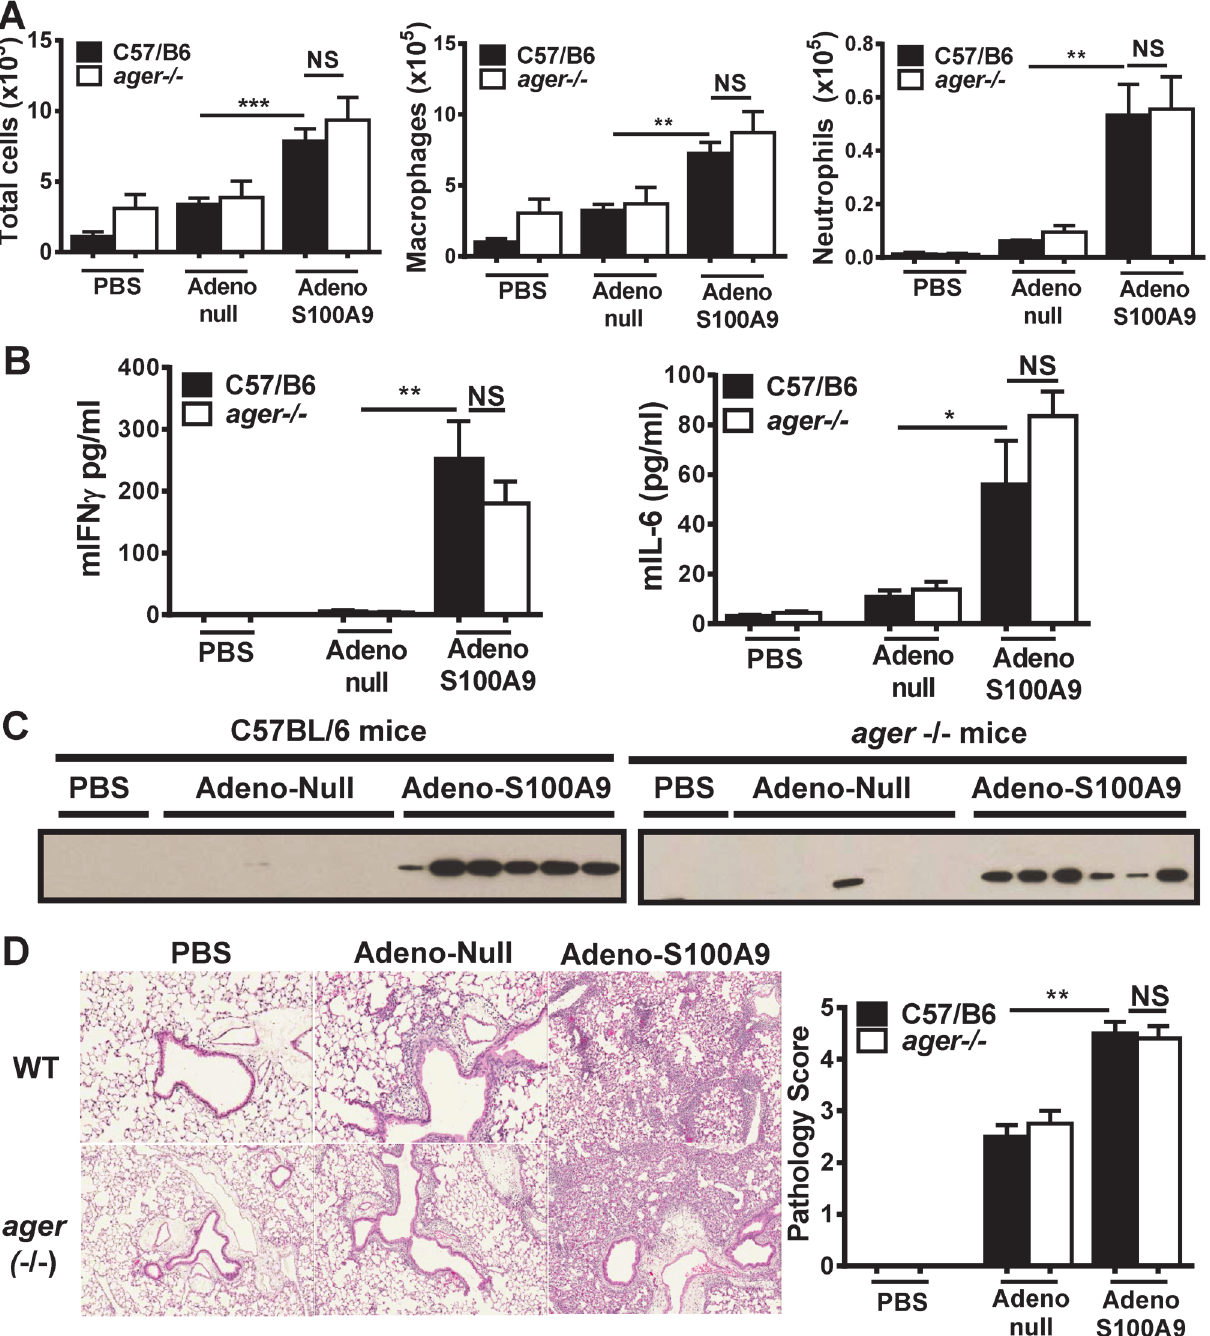
Fig 6. Murine S100A9 induced lung inflammation is RAGE-independent. Wild type C57Bl/6 or C57Bl/6 ager -/- mice were challenged intranasally with PBS, or adeno-null or adeno-murine S100A9, after 8 days, mice were sacrificed and BAL fluids or lung tissue were collected for analysis. (A) Cells were obtained from the BAL fluids using cytospins, stained with diff-quik and the total cell counts, neutrophil counts and macrophage counts were recorded. (B) mIFN γ and mIL-6 proteins levels found in BAL fluids of wild type and ager -/- mice. (C) Western blot analysis of murine S100A9 levels in BAL fluids. (D) H&E staining of paraffin fixed lung tissue (left panel), and pathology scores (right panel). Non-parametric Mann-Whitney test was used to determine statistical difference between two groups.